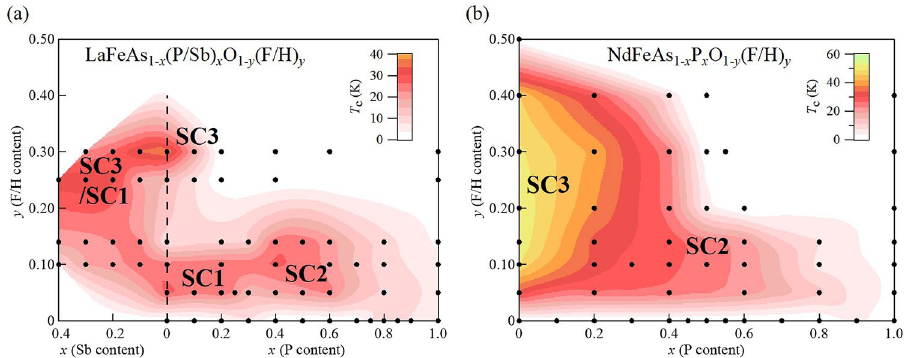
Figure 5. Schematic phase diagrams of ( a ) LaFeAs 1 − x (P/Sb) x O 1 − y (F/H) y and ( b ) NdFeAs 1 − x P x O 1 − y (F/H) y . Dots represent the compositions examined in this study. Contour lines of T c are drawn by extrapolation using the data of Figs. 3 and 4, “Supplementary materials”, and previous results 27–29 .